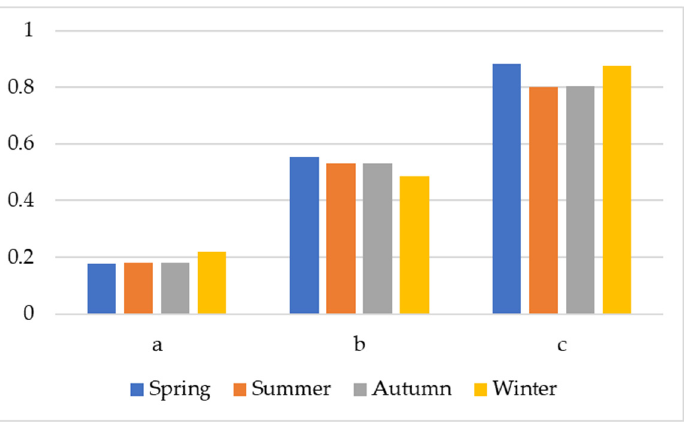
Figure 9. Seasonal average values of coefficients a, b and c for the Sen Model for all stations.